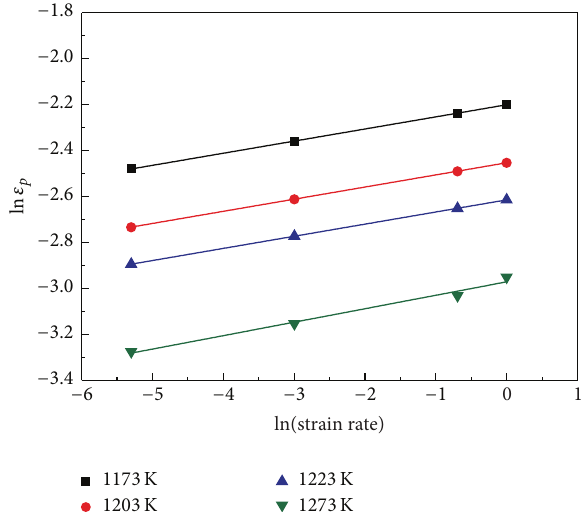
Figure 10: The relationships between ln 𝜀 𝑝 and ln ̇𝜀 .